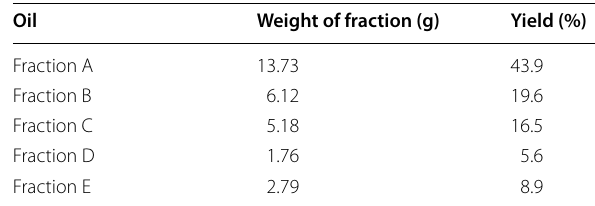
Table 3 Yields of the fractions (A–E) isolated from P. densiflora wood